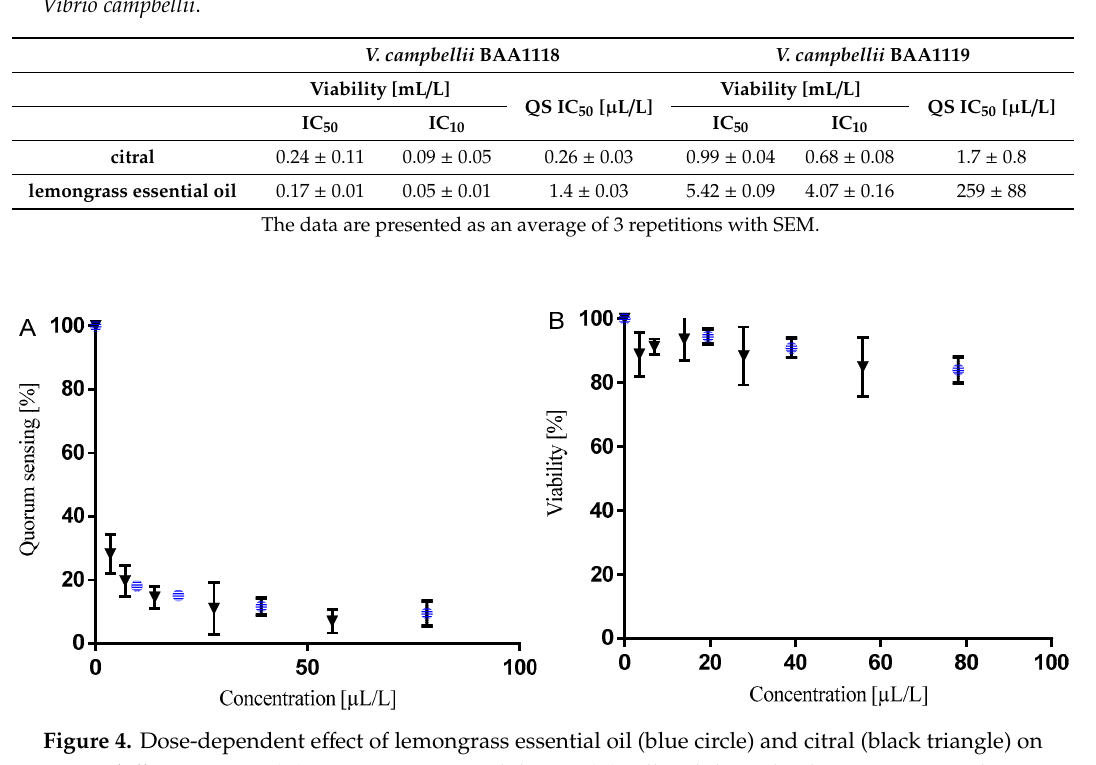
Figure 4. Dose-dependent effect of lemongrass essential oil (blue circle) and citral (black triangle) on V. campbellii BAA1118: ( A ) quorum sensing inhibition, ( B ) cell viability. The data are presented as an